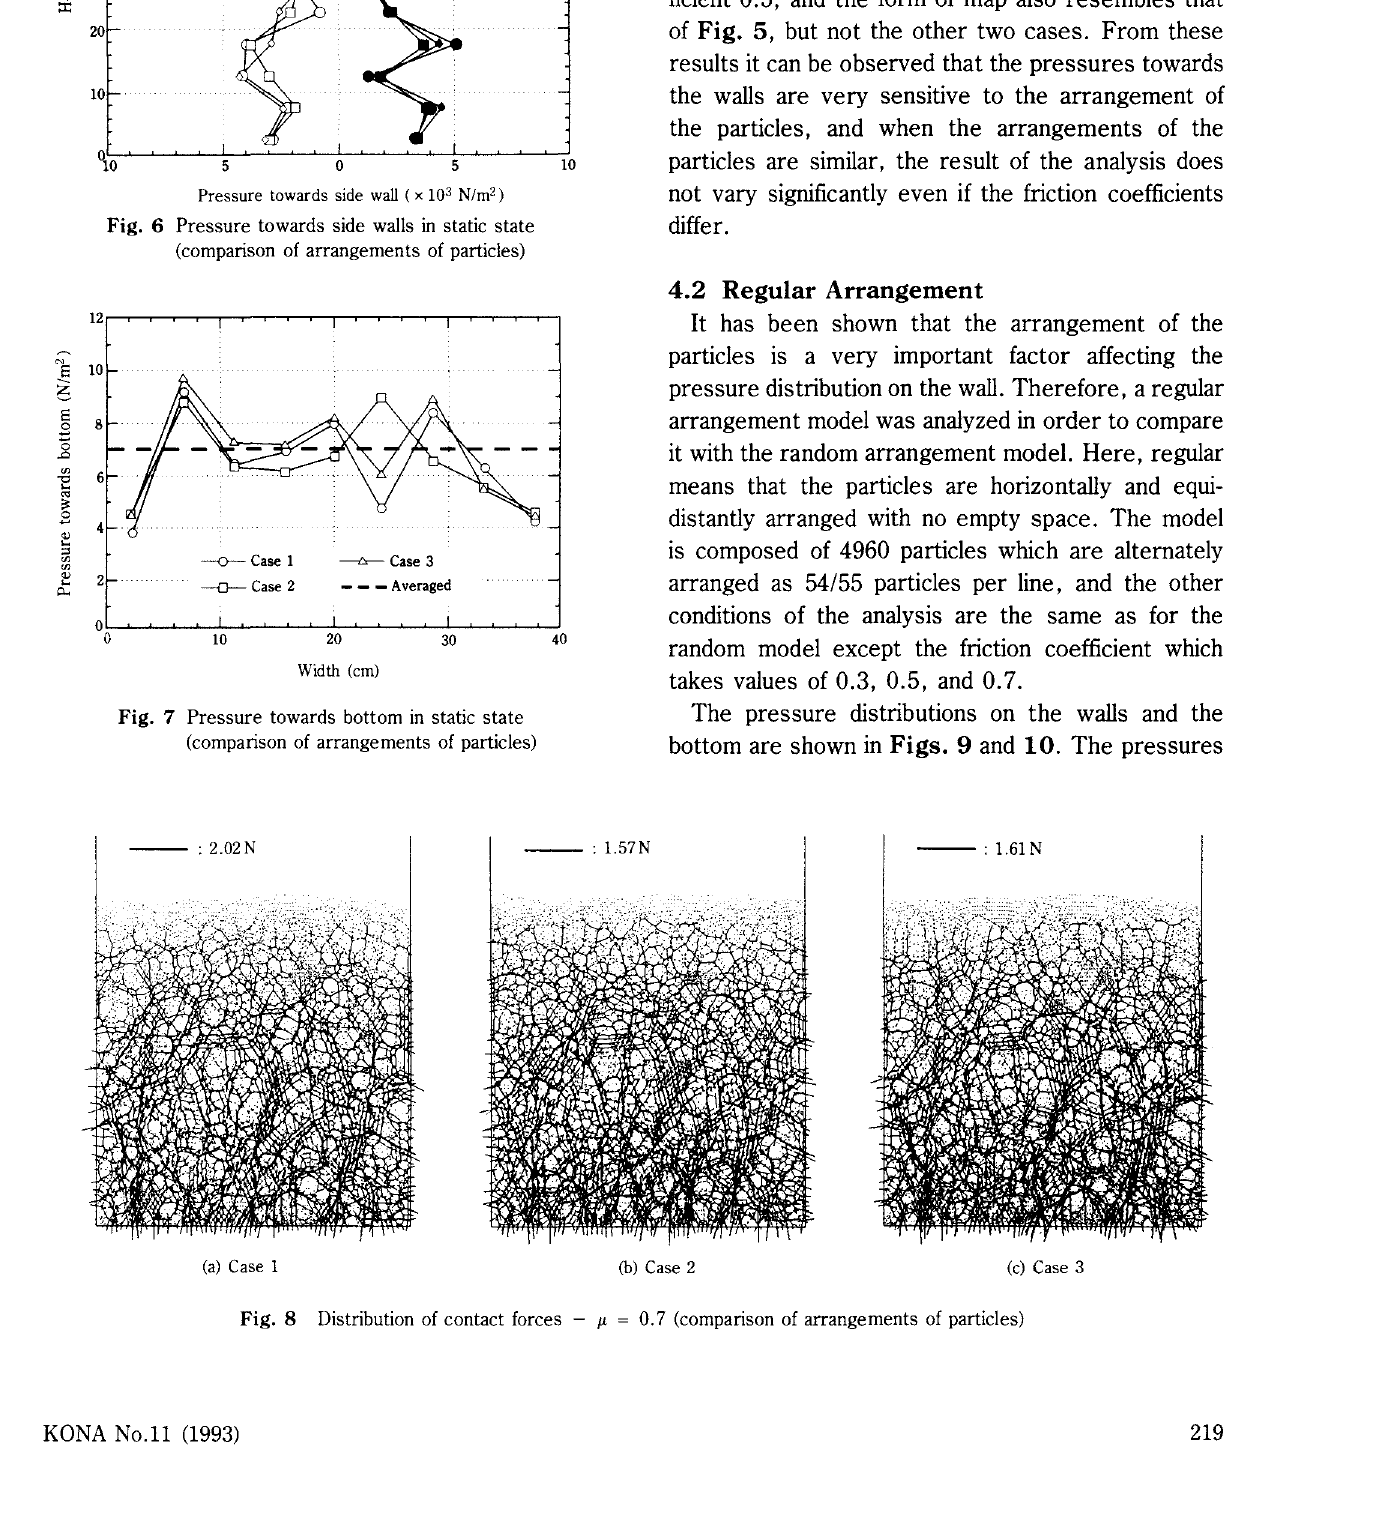
Fig. 6 Pressure towards side walls in static state (comparison of arrangements of particles)